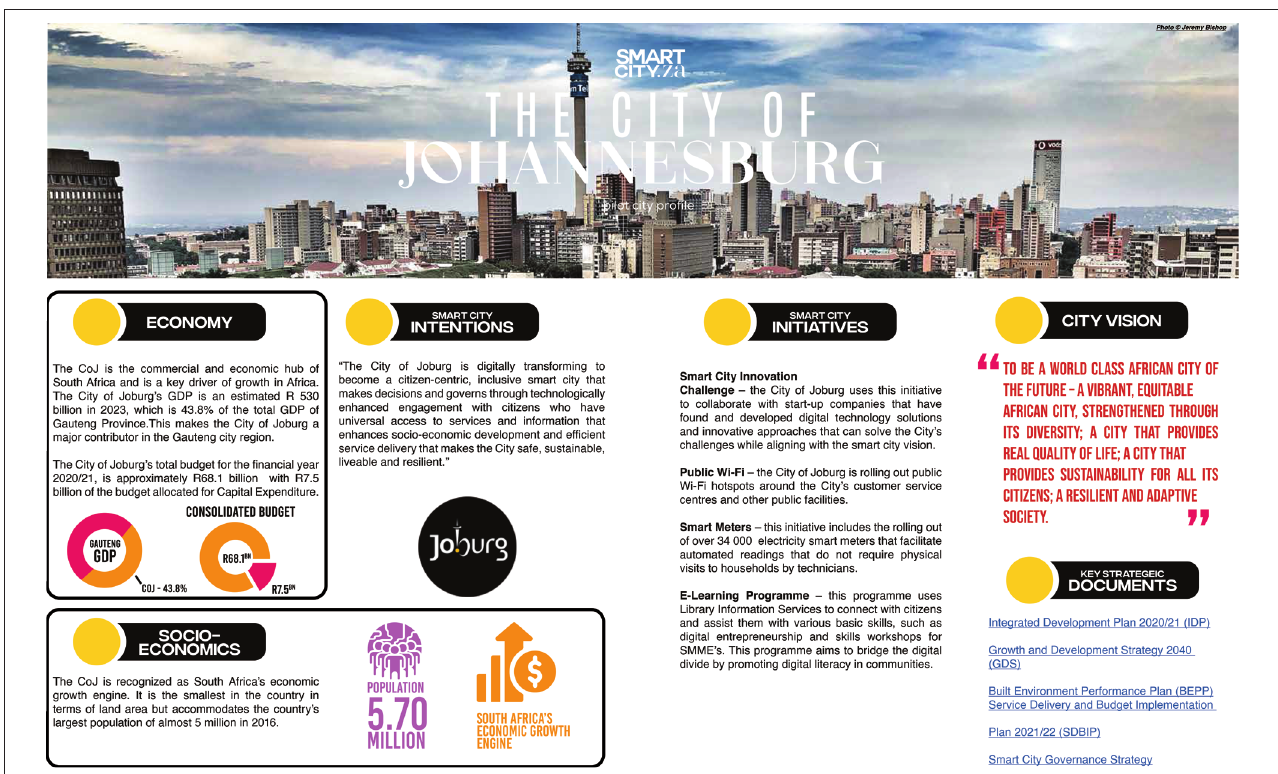
FIGURE 4: The City of Johannesburg